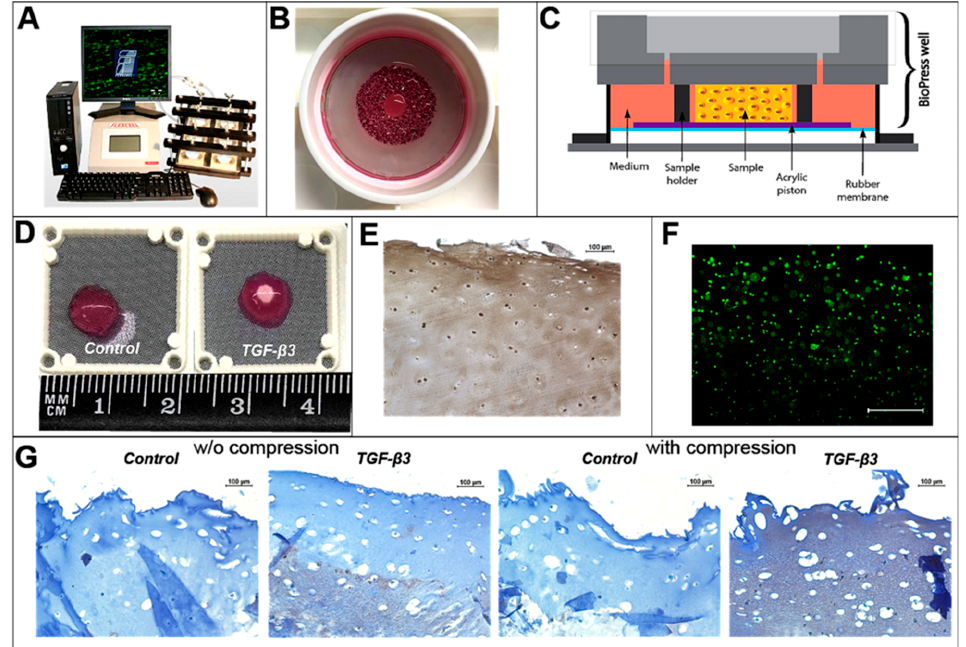
Figure 3. The chondrogenic differentiation of BM-MSCs incorporated into CS-Tyr/Gel hydrogels for 21 days of chondrogenic differentiation with and without the mechanical load. ( A ) Flexcell FX-5000 system. ( B ) Flexcell plate with the CS-Tyr/Gel/BM-MSCs. ( C ) Schematic representation of Flexcell compression. ( D ) The CS-Tyr/Gel/BM-MSCs with and without the TGF- β 3 21 days after the chondrogenic differentiation. ( E ). Immunohistochemical positive staining control of collagen type II in human cartilage explant. ( F ) Viability of BM-MSCs in CS-Tyr gel at the 21st day of chondro- genic differentiation stained with live/dead kit and visualized with fluorescent microscope ( × 40). ( G ) Immunohistochemical collagen type II staining in CS-Tyr/Gel/BM-MSCs composite 21 days